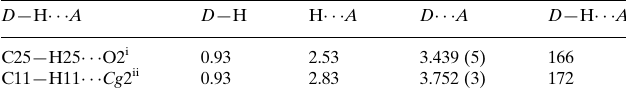
Hydrogen-bond geometry (A˚ , (cid:2) ). Cg 2 is the centroid of the C1–C6